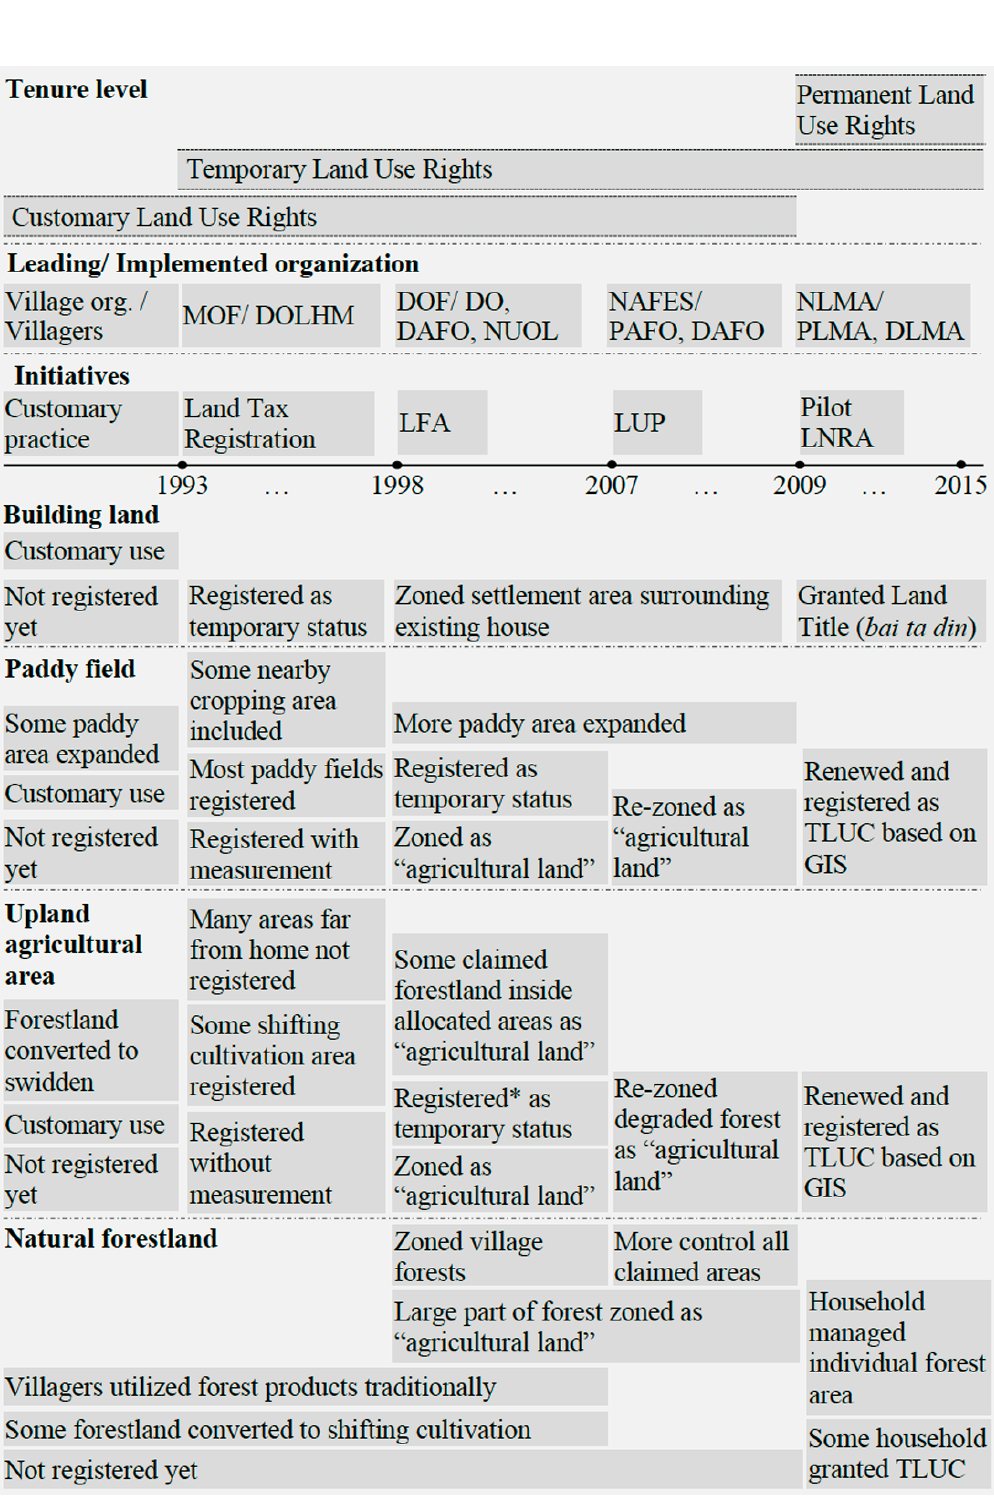
Figure 4. Historical changes of household land tenure in the study village. Source: Based on information of consultation meeting with local authorities and group discussion with village organizations. * Based on information in [49].